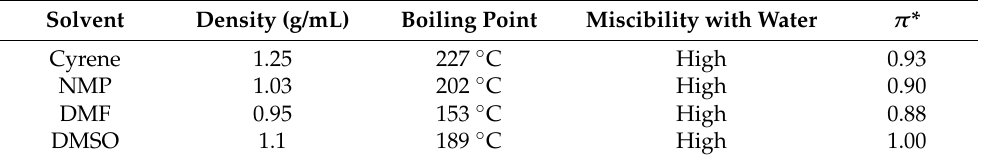
Table 1. Physical properties of Cyrene in comparison to NMP, DMF and DMSO. Solvent Density (g/mL)